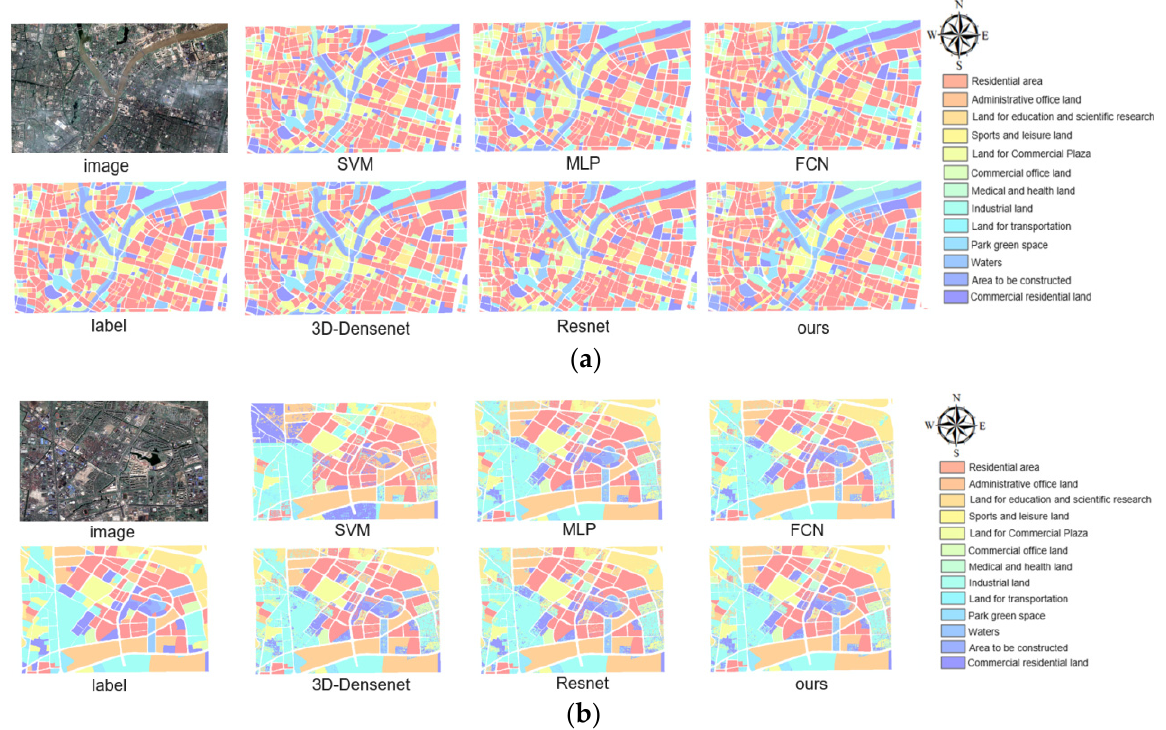
Figure 11. Visualization results: ( a ) Area_1 Visualization results; ( b ) Area_2 Visualization results. Table 5. Per category results for Area_1. The best results are highlighted in bold.